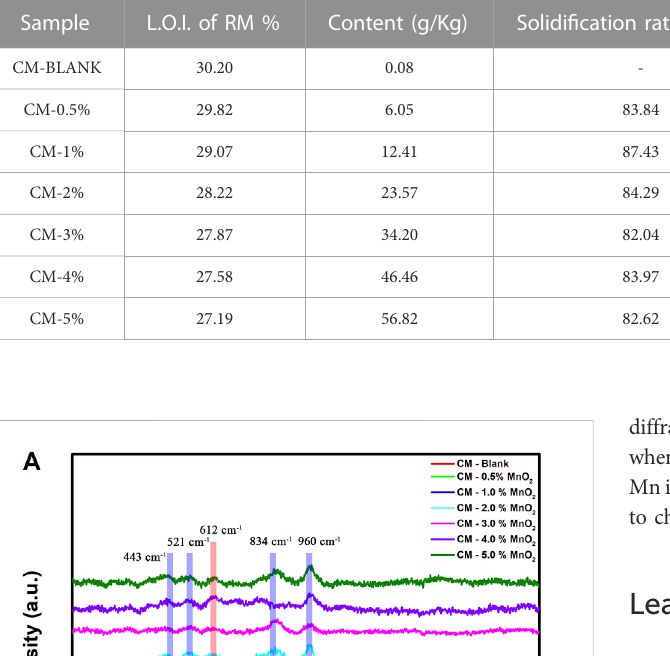
TABLE 3 Leaching test and solidi fi cation ratio of the Mn doped clinker material samples. Sample